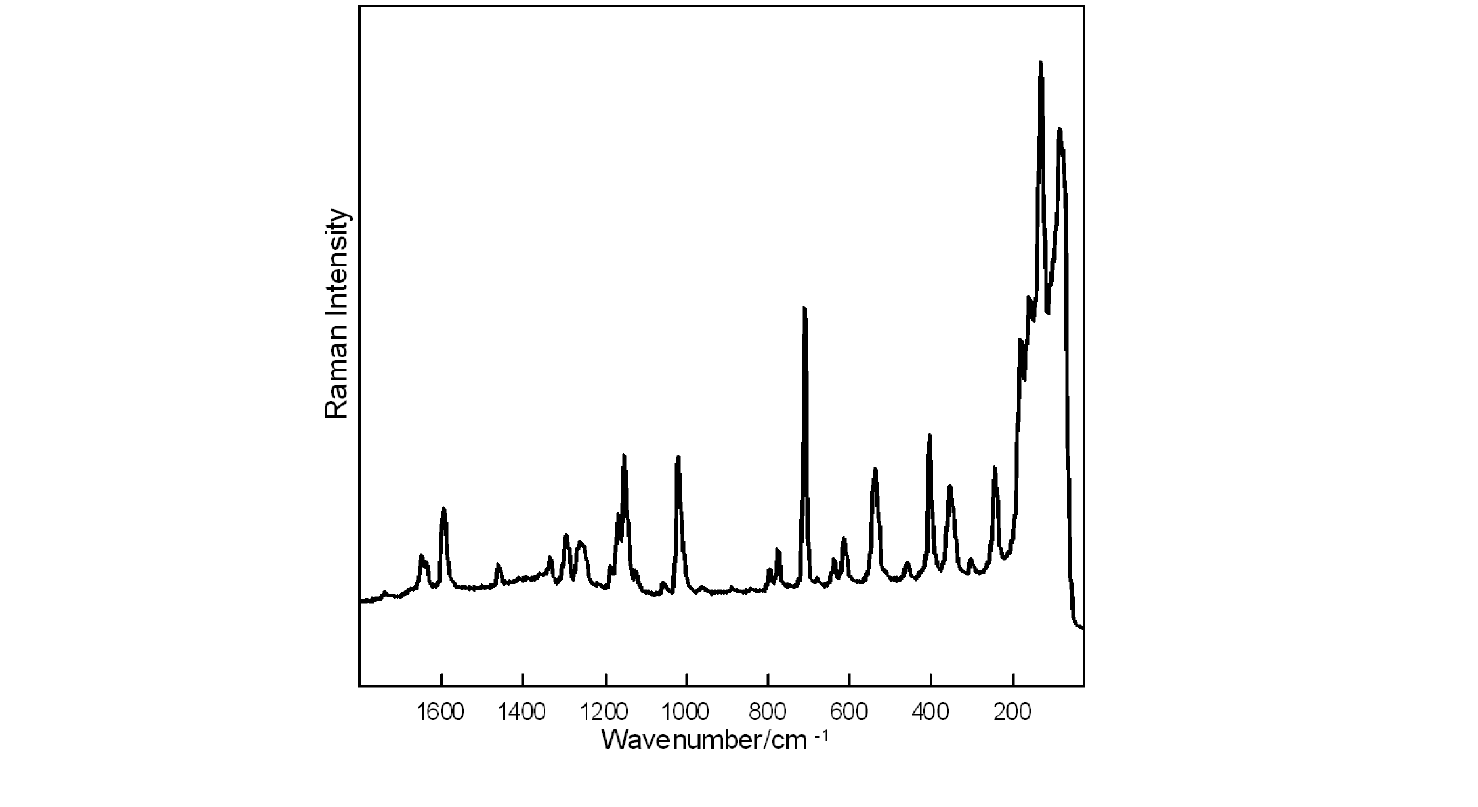
Fig. 7 The Raman spectrum of K 3 (sac) 3 ¢ 2H 2 O in the 1750-50 cm ¡ 1